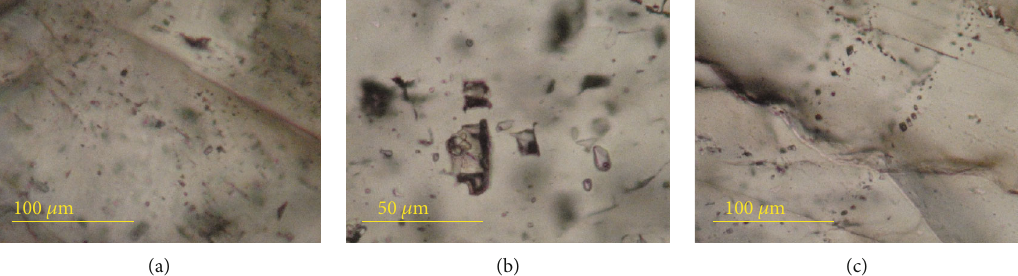
Figure 9: Fluid inclusions: (a) protogenetic brine inclusions in saddle dolomite, (b) rectangular or elliptical and isolated protogenetic brine inclusions in cloudy-centered dolomite, and (c) isolated protogenetic brine inclusions in coarse-grained